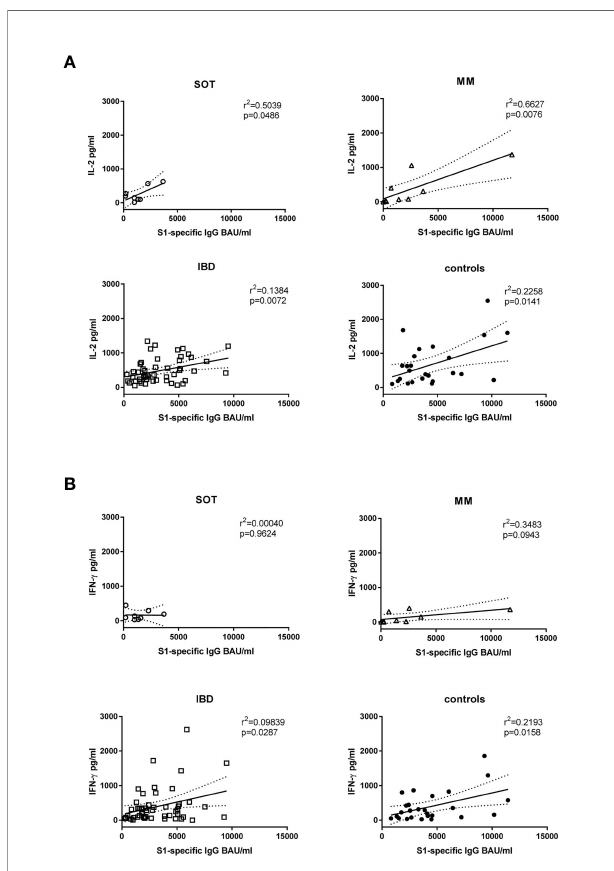
FIGURE 3 | Correlation of antibody levels with cytokine production. The IL-2 (A) and IFN- g (B) levels shown in Figure 2 were correlated with the S1- speci fi c IgG antibody levels of week four after the second mRNA dose. SOT (n=8) are represented as open circles, MM (n=9) as open triangles, IBD (n=52) as open squares and controls (n=26) as full circles. Differences between the groups below p values of 0.05 were regarded as signi fi cant. Dotted lines represent 95% con fi dence